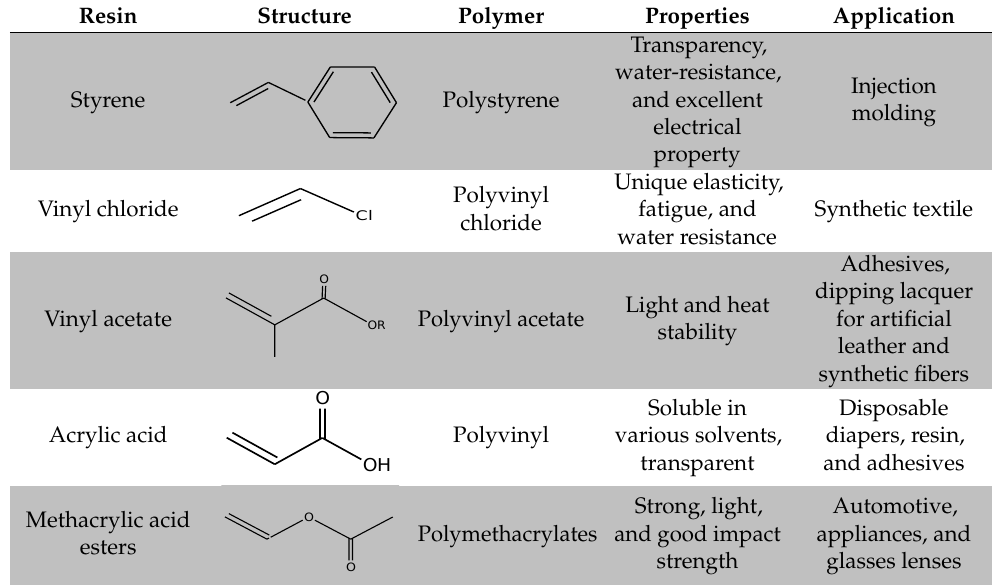
Table 1. Common resins on the market [90].